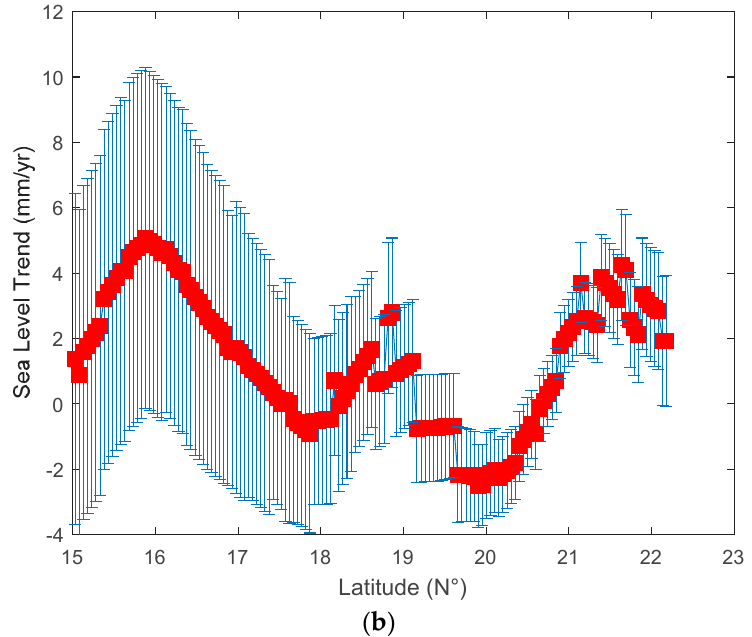
Figure 8. Regional 6.5 yr-long trends in sea level derived from the CCI sea level data. ( a ) using gridded data and ( b ) interpolated along the Jason-2 pass 153. Vertical blue bars in Figure 8b represent the uncertainty on the trend estimation.